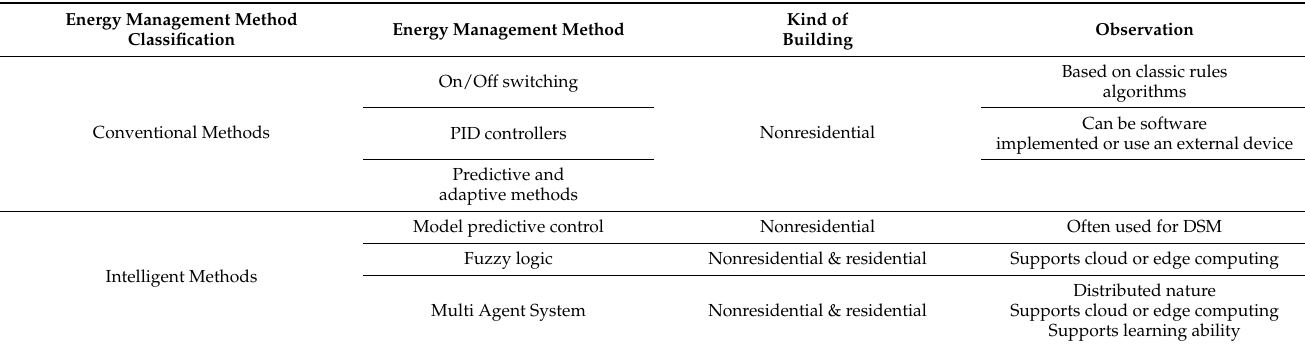
Table 1. Active energy management methods for